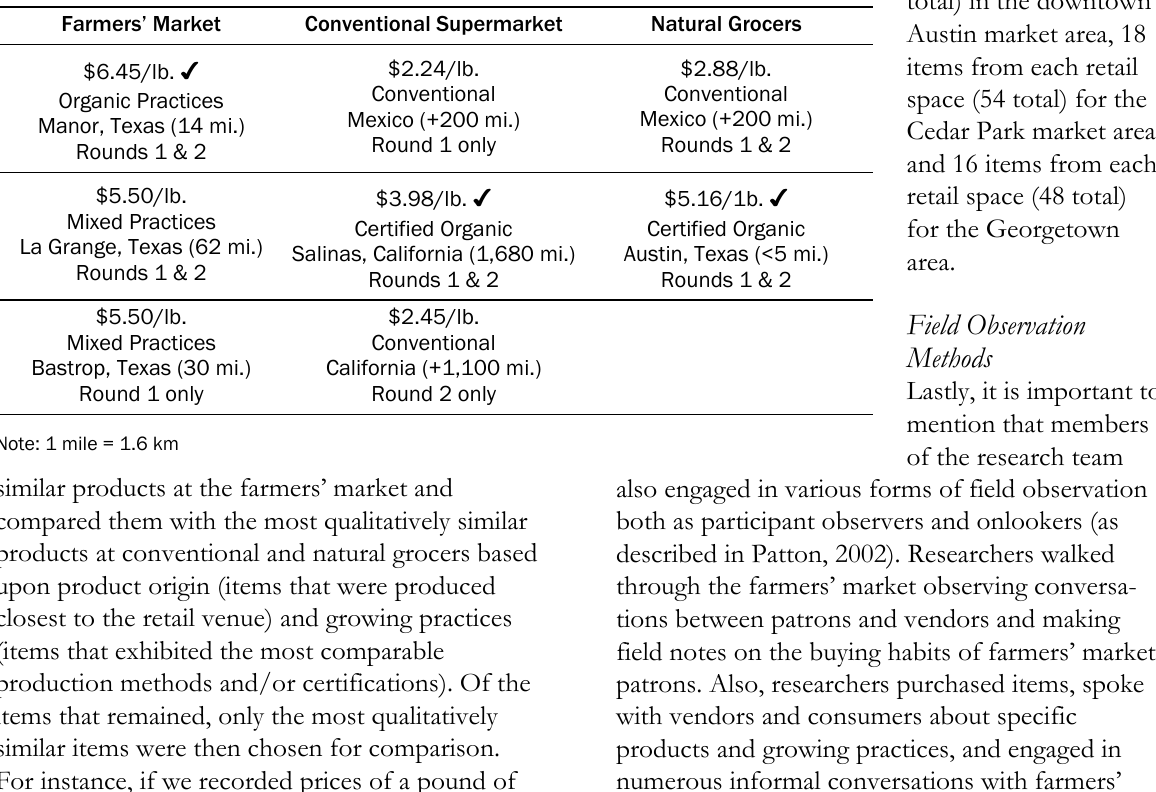
Table 1–B. Product Selection Chart (all prices in US$) ( ✔ indicates items chosen for